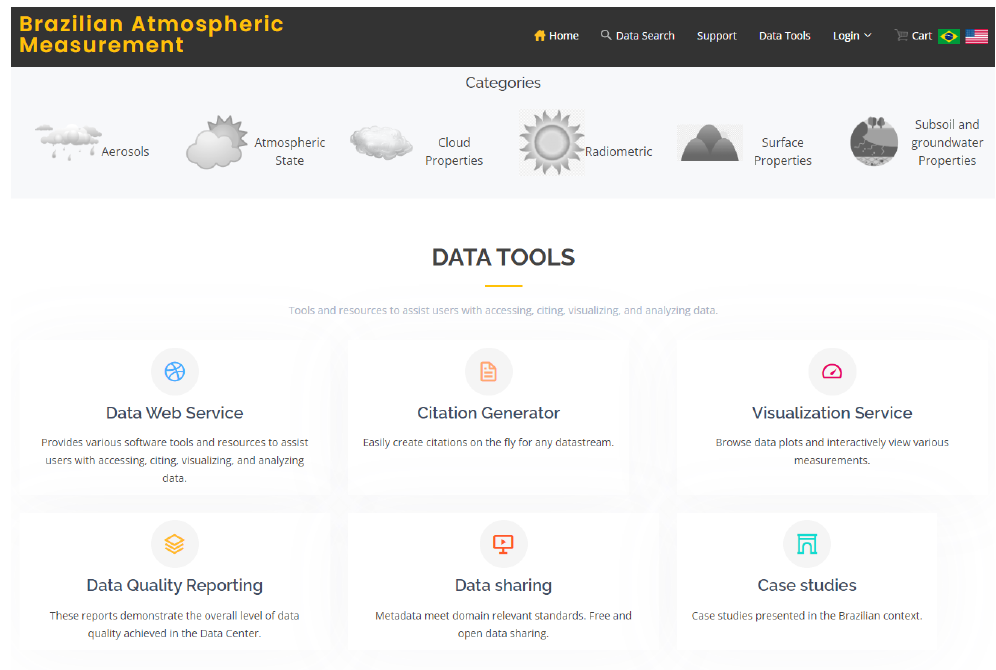
Figure 10. Data portal interface for Publishing and Delivery of Open